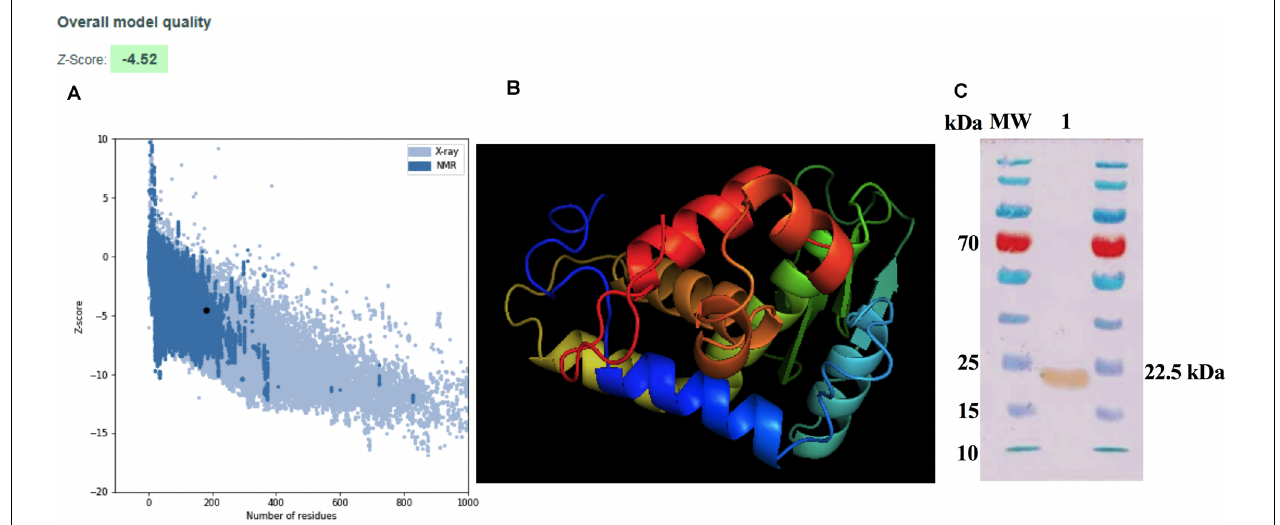
FIGURE 1 | Modeling and purification of Zn-dependent metalloproteinase. (A) ProSA-web Z-score plot for 3D structure of the hypothetical protein after refinement. The Z-score of the final model is − 4.52. The black dot represents the hypothetical protein. (B) 3D structure according to the I-TASSER server after being refined and visualized by Chimera PyMOL. (C) Purification of the ZnMP codifying for ORF BAB1_0270 of B. abortus 2308. ZnMP sequences were cloned in the expression vector pColdII (pColdII-ZnMP), and the recombinant vector was used to transform the Escherichia coli BL21 (DE3) strain. Western blot was performed to visualized protein using anti-6x-HisTag antibodies. MW: molecular weight marker in kDa; 1: recombinant protein purified from E. coli